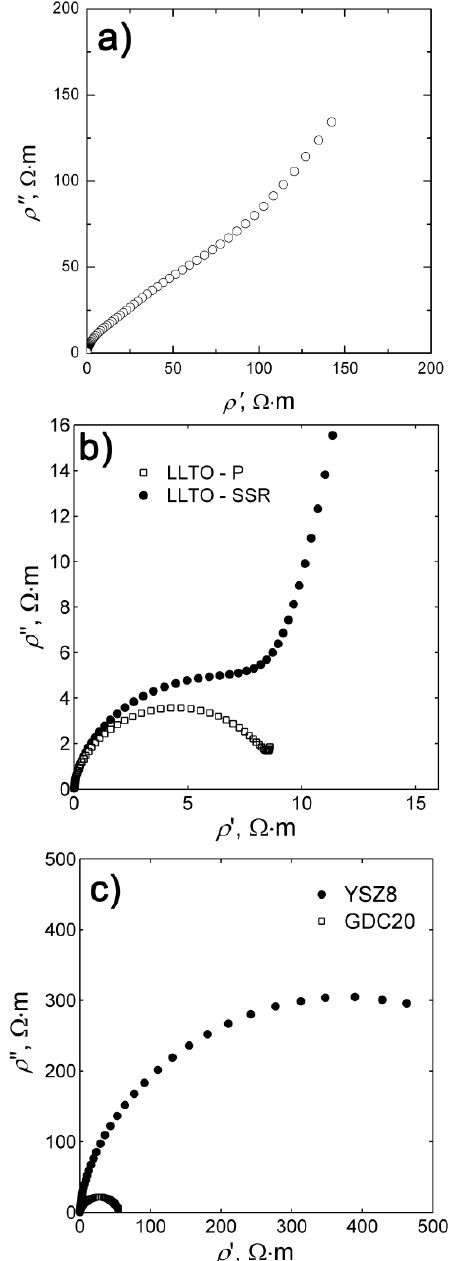
Figure 3: High frequency impedance complex plain plots of: Li3Ti1.5(PO4)3 at 300 K (a), LLTO at 300 K (b), and YSZ8, GDC20 at 600 K (c).